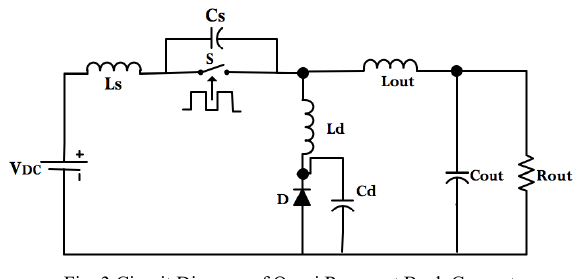
Fig. 3 Circuit Diagram of Quasi Resonant Buck Converter